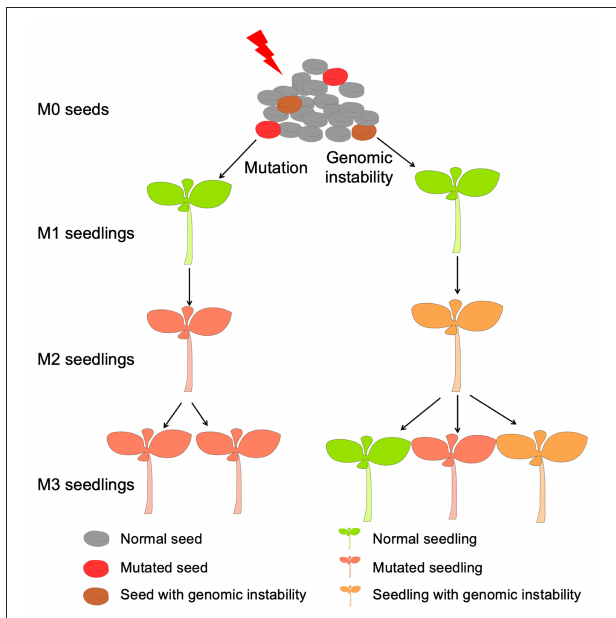
FIGURE 2 | Two sources of the mutant in progeny, left shows that the mutant originated from direct transmission from irradiated seeds, right shows that the mutant was formed through genomic